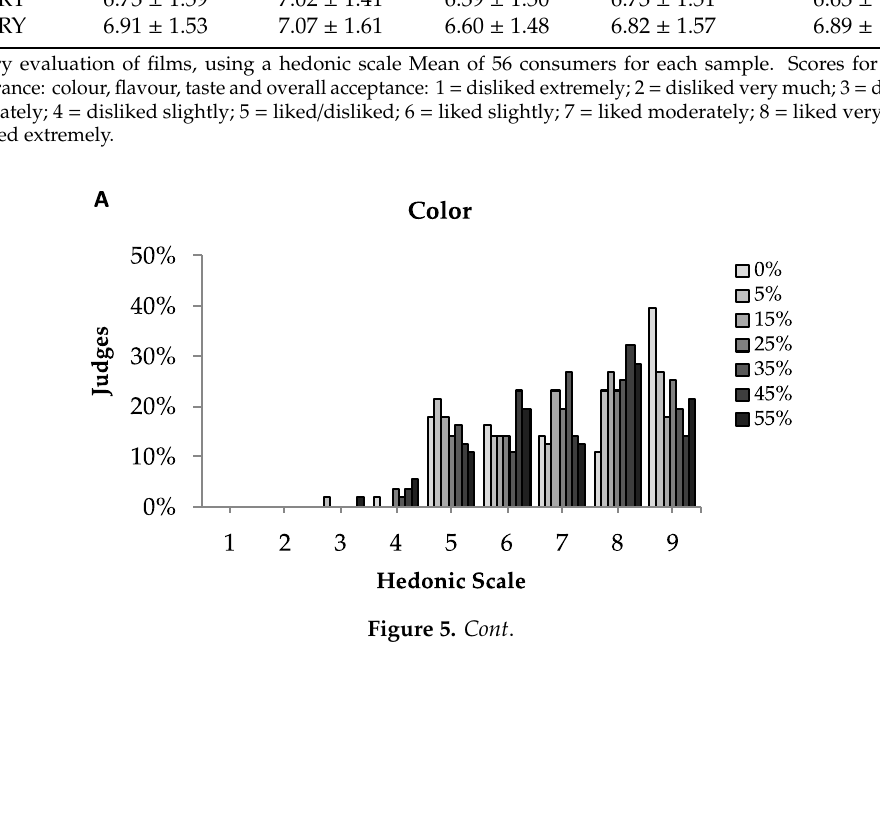
Table 1. Results of sensory evaluation